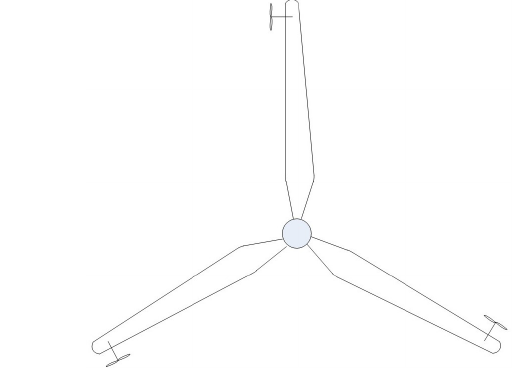
Figure 2. Rotor with secondary rotors. Figure 3. Distributions of axial induction for arbitrary choices on n and p